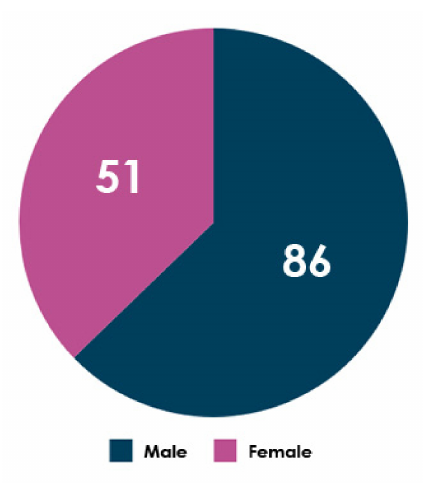
Figure 4. Age distribution of COVID-19 (+) patients.